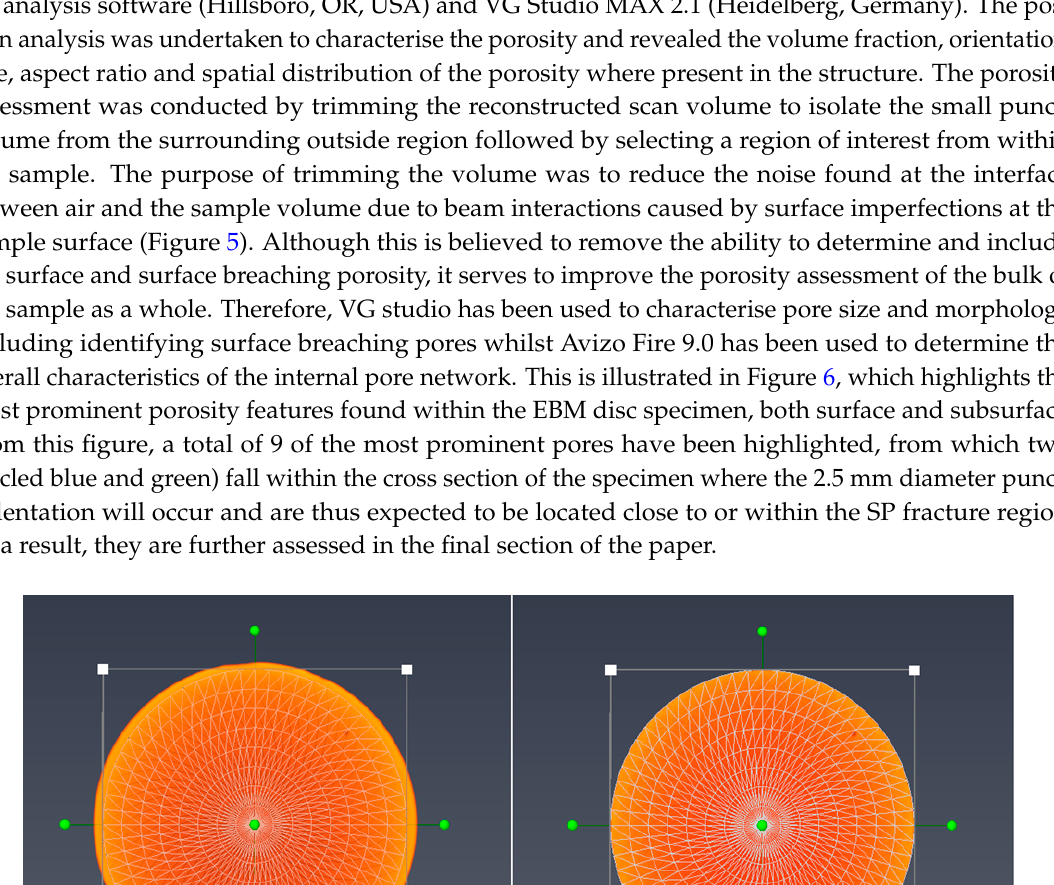
Figure 6. Porosity network in the EBM SP specimen using Avizo 9.0. Figure 7a illustrates the 3D volume render of the EBM disc after greyscale thresholding within VG studio and indicates the size of porosity through the structure. Figure 7b indicates the largest pore in the specimen, which measures approximately 0.14 mm in diameter from within the bulk of the material. Due to its size it is believed that this feature is a byproduct of the manufacturing process rather than being the result of residual gas pores originating from the manufacture of the powder as this size falls considerably outside the powder size distribution (45–100 μ m). The overall porosity data is summarised in Table 3, which contains the porosity calculations for each of the three Ti-6Al-4V variants.